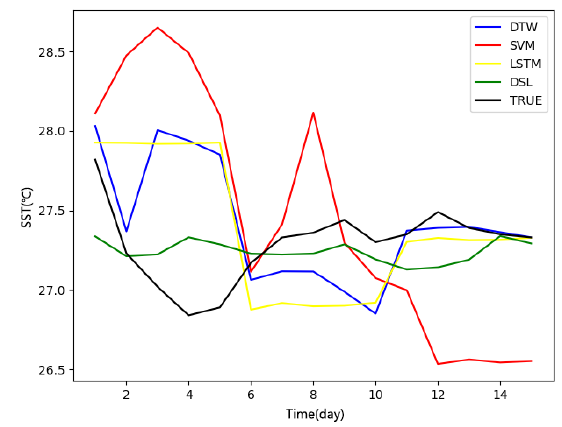
Figure 6. Comparison of SST prediction results by different methods, where black line is ground truth, green line is our model’s prediction.